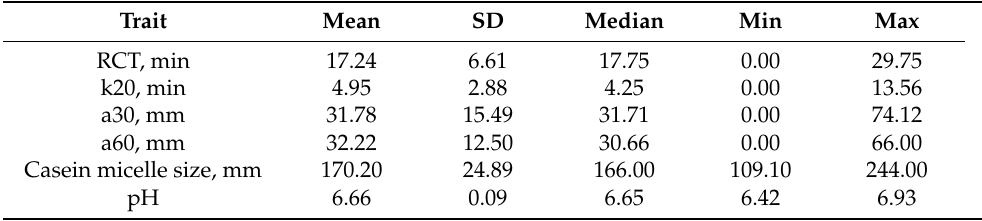
Table 1. Mean, standard deviation (SD), median, minimum (Min), and maximum (Max) values for the 6 technological traits